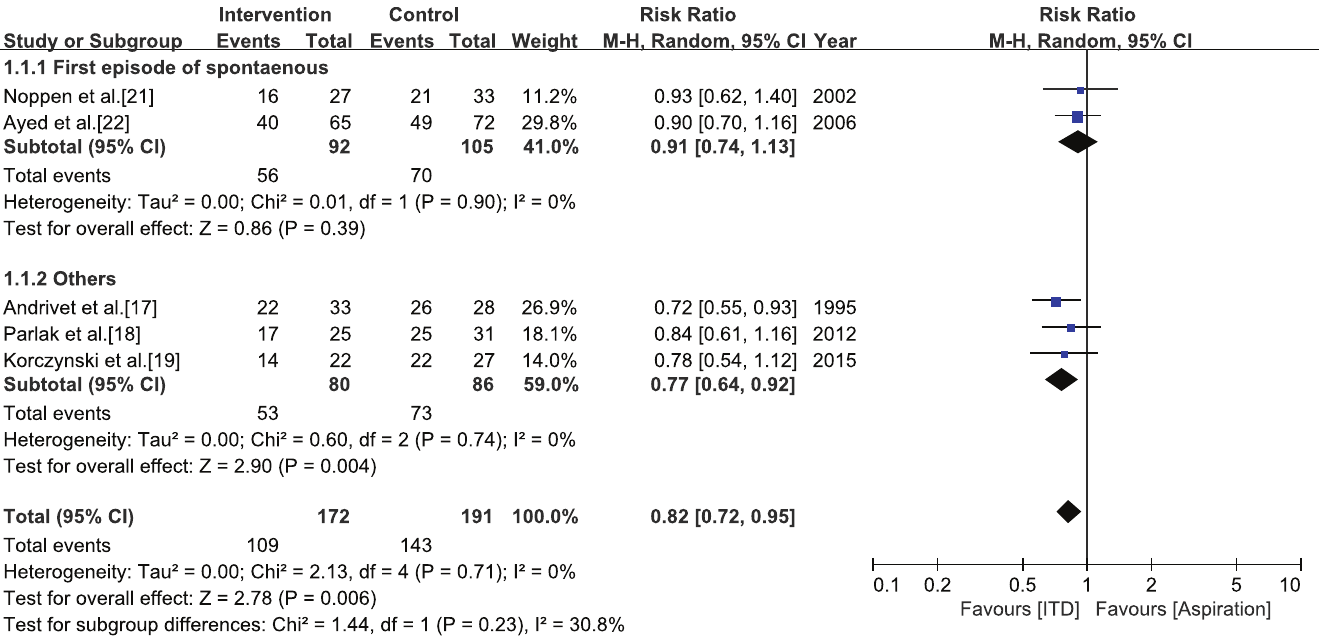
Fig 3. Subgroup analysis of the studies that compared aspiration and intercostal tube drainage. The subgroupingswere assignedaccordingto the subtype of pneumothorax includedin each study; i.e., first episodeof primary spontaneous pneumothorax versus other types.